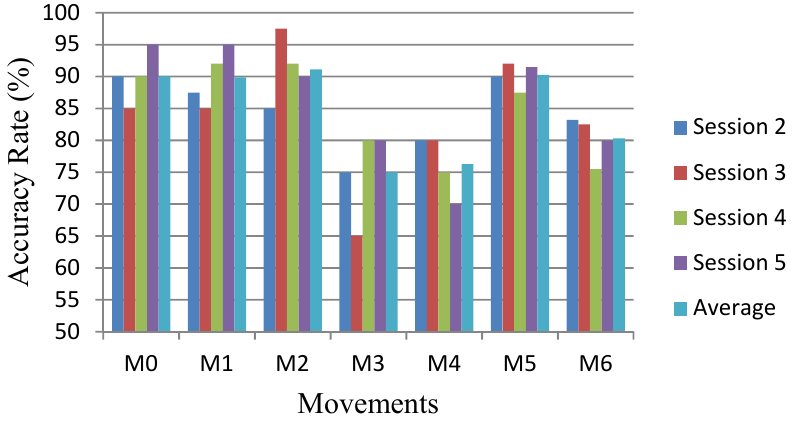
Figure 9. Overall result of the system for each